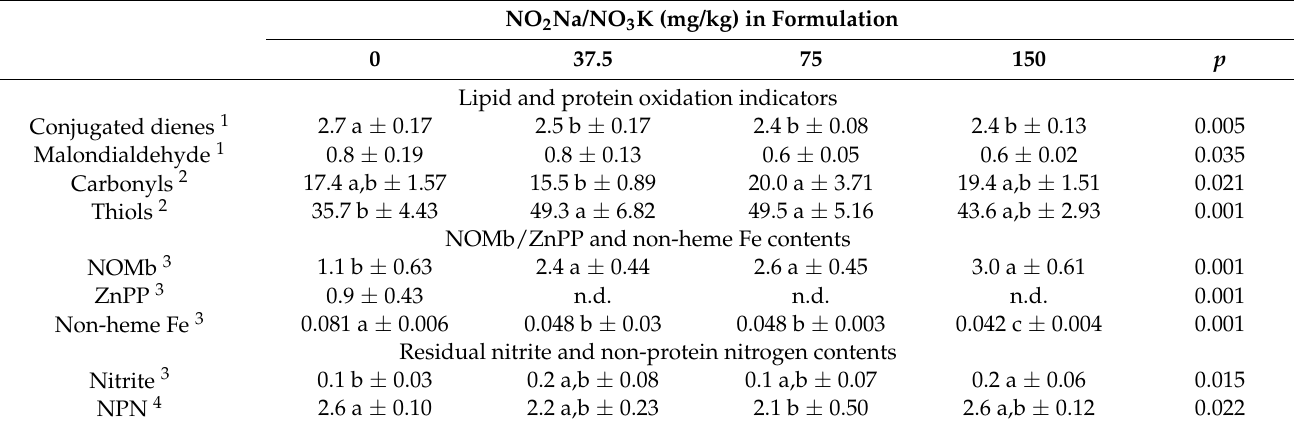
Table 3. Conjugated dienes, malondialdehyde, carbonyls, thiols, residual nitrite, non-nitrogen protein, NOMb, ZnPP, and non-heme iron in dry-cured loins used in the in vitro gastrointestinal